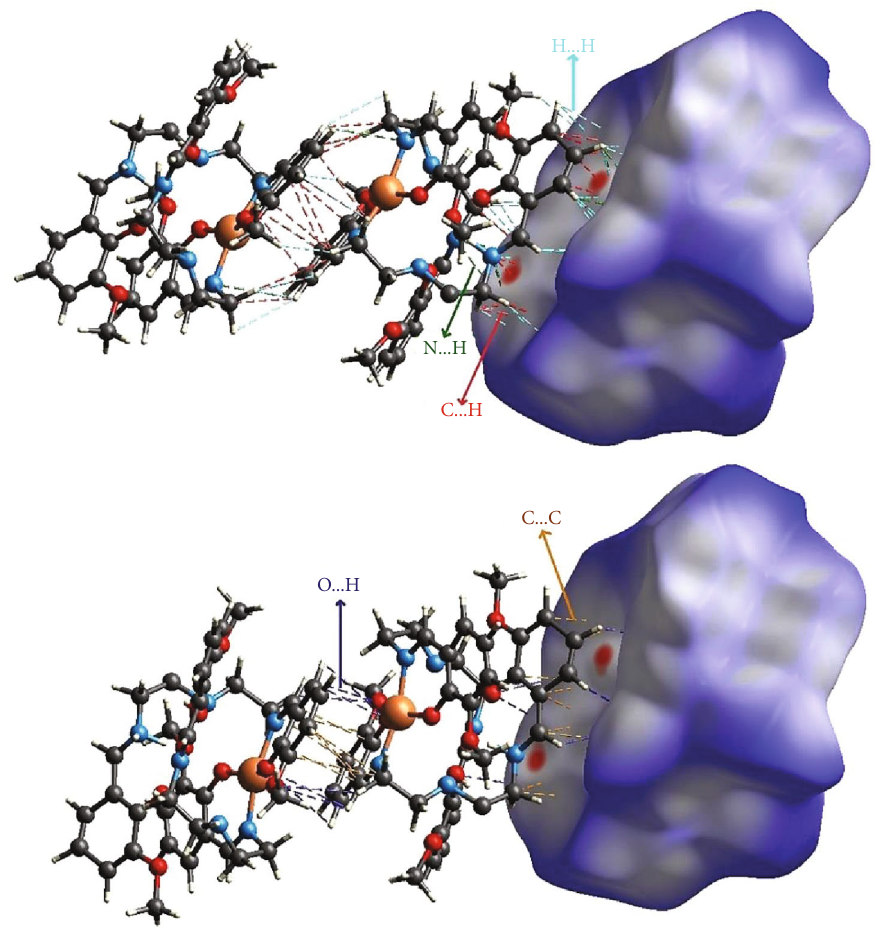
Figure 7: HS displaying the intermolecular interactions of Cu(H